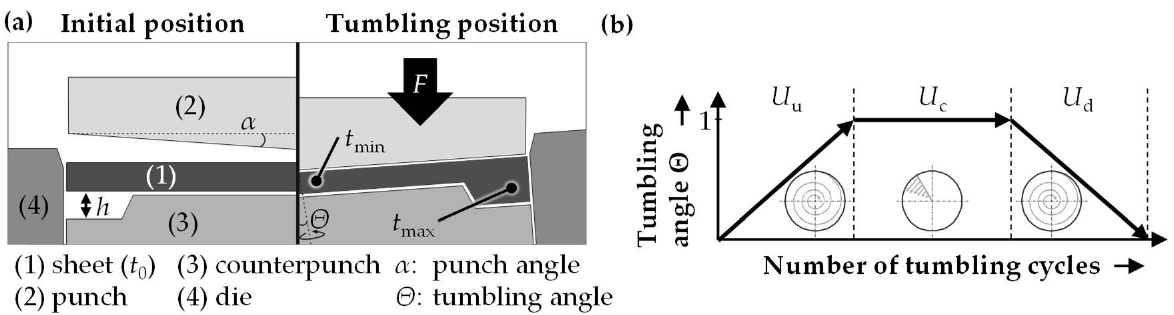
Figure 7. ( a ) Process setup and ( b ) characteristics of orbital forming [4].